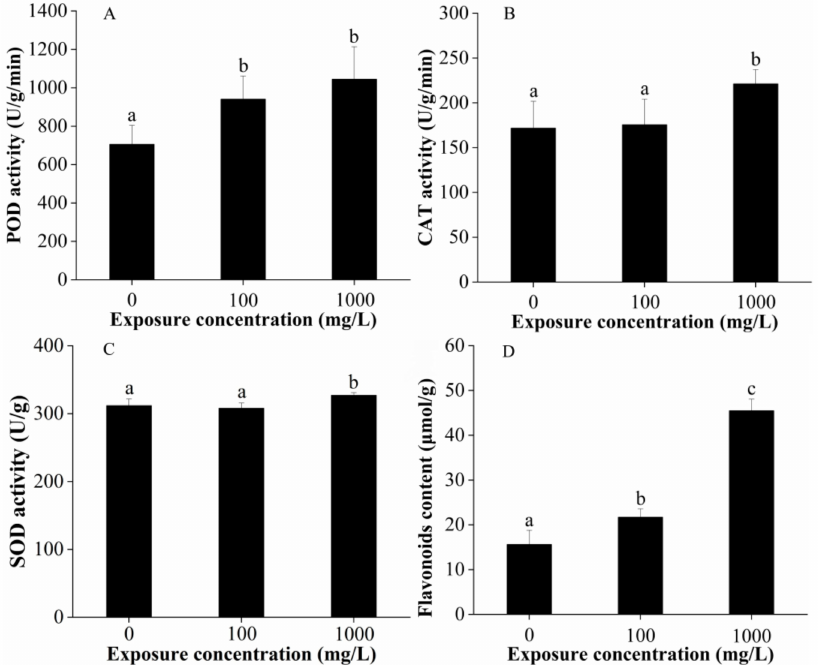
Figure 4. POD activity ( A ), CAT activity ( B ), SOD activity ( C ) and flavonoids content ( D ) in lettuce leaves after 15 days of foliar exposure to CuO-NPs (0, 100, and 1000 mg/L). Values are expressed as the mean of five replicates ( ± SD) for each treatment; the different lowercase letters (a, b, and c) indicate significant difference at p < 0.05 among different exposure concentrations, mean values with the same letter are not significantly